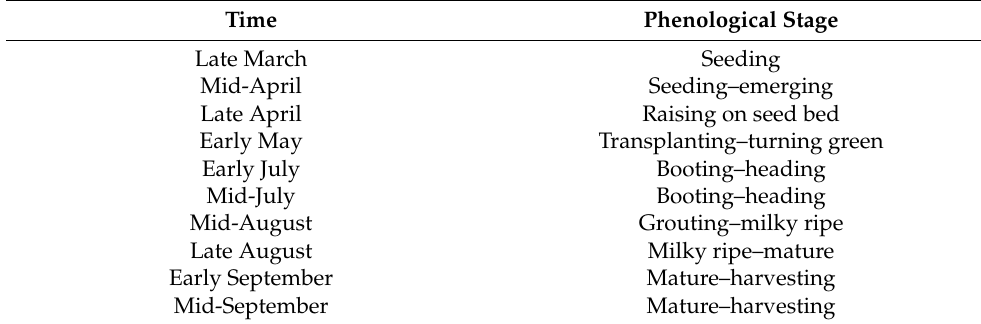
Table 1. Phenological stage of rice growth in the study